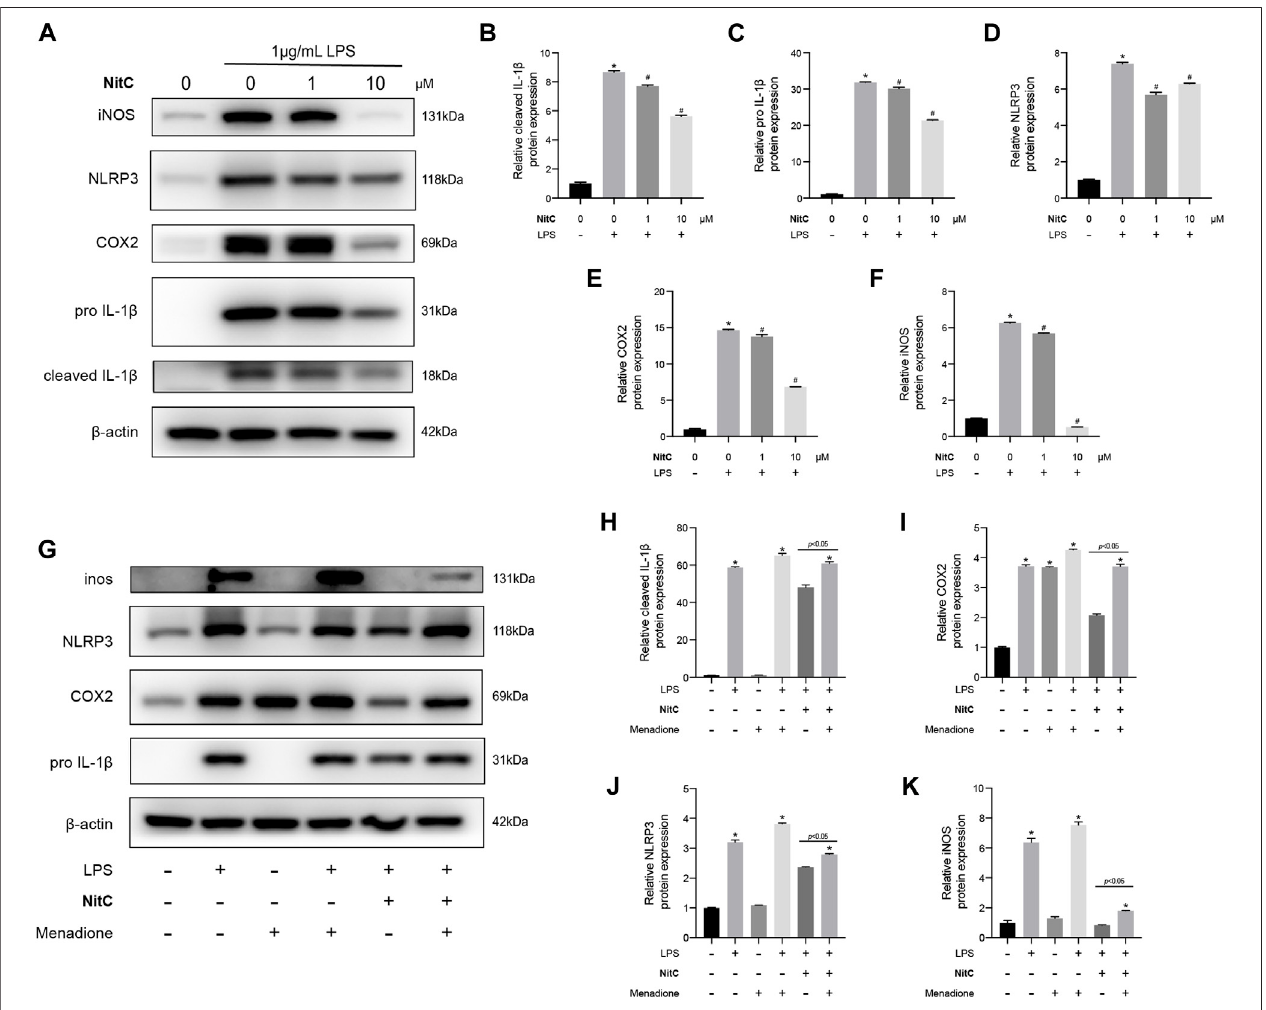
FIGURE 6 | NitC inhibited NLRP3-in fl ammasome activation through scavenging ROS. (A) The WB analysis and quantitative analysis of the (B) cleaved IL-1 β , (C) pro-IL-1 β , (D) NLRP3, (E) COX2,and (F) iNOS. (G) AnotherWBanalysiswasperformedtoinvestigatetheroleofROSinNitC-treatedRAW264.7.Thequanti fi edresults of (H) pro-IL-1 β , (I) COX2, (J) NLRP3, and (K) iNOS were shown in the fi gure. p p < 0.05 versus the model group, other signi fi cant differences between the groups were shown as indicated in the fi